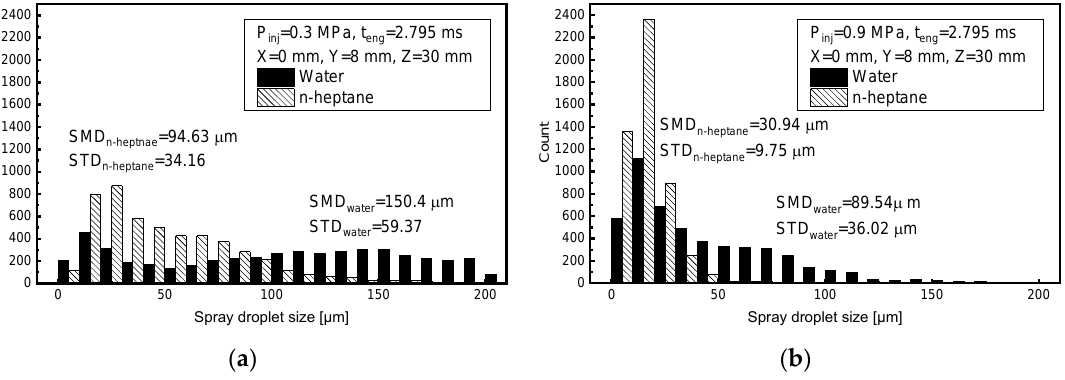
Figure 10. Droplet size distribution of water and n-heptane under two injection pressure at ( a ) P inj = 0.3 MPa, ( b ) P inj = 0.3 MPa (t eng = 2.795 ms, X = 0 mm, Y = 8 mm, Z = 30 mm).